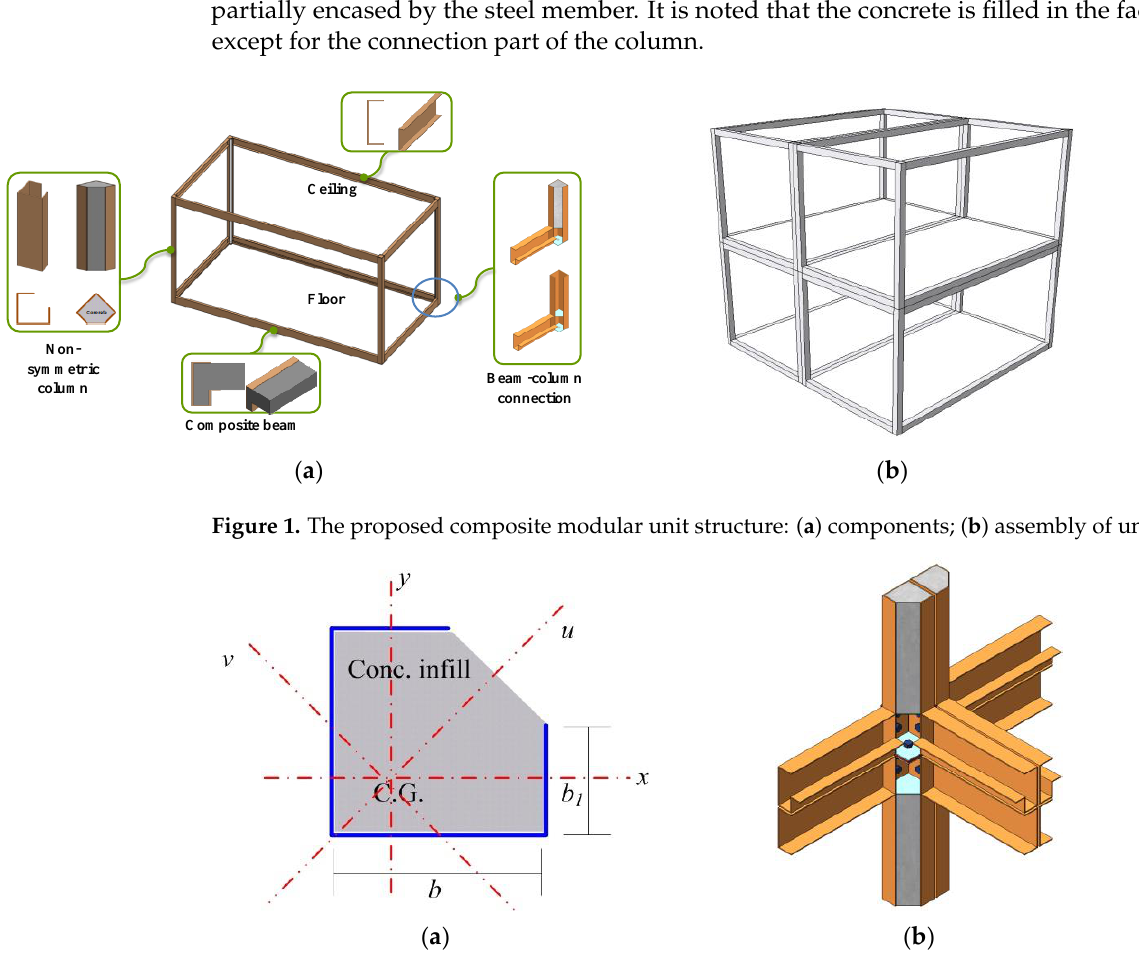
Figure 2. Nonsymmetrical composite column: ( a ) cross section; ( b ) connection between modules.